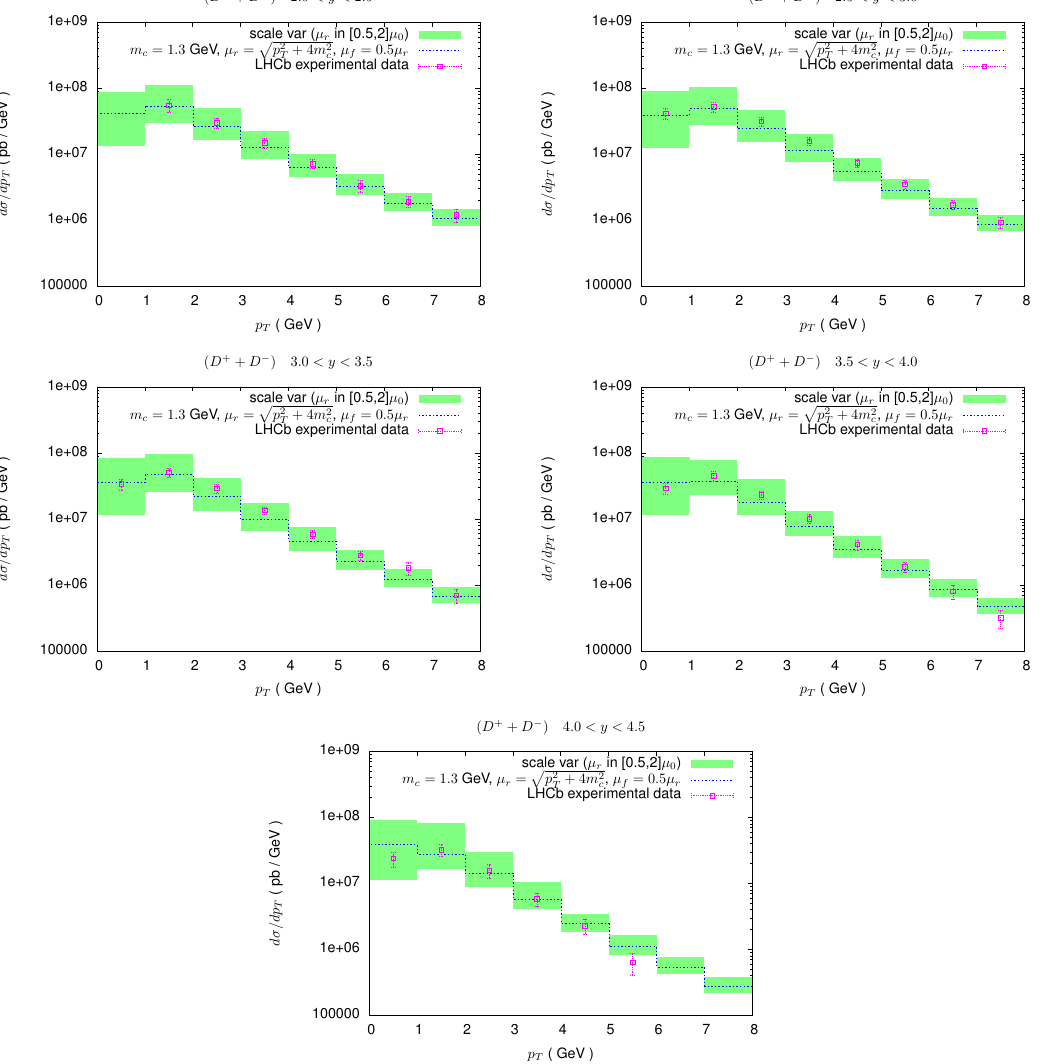
Figure 3 . Our GM-VFNS predictions for ( D + + D (cid:0) ) transverse-momentum distributions for pp collisions at p S = 7 TeV vs. LHCb experimental data of ref. [42]. Each panel corresponds to a di(cid:11)erent rapidity bin in the interval 2 < y < 4 : 5. The scales are chosen as in (cid:12)gure